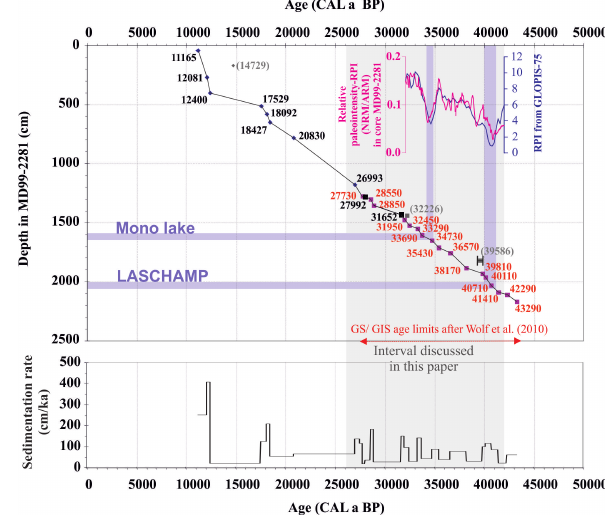
Fig. 4. Age model and sedimentation rates for the last 50kaBP in core MD99-2281 (see also Table 1). Dates in red are those de- duced from the correlation (see also Fig. 3) of the MS record and the NGRIP GICC05 δ 18 O (Wolff et al., 2010). A comparison of the relative paleointensity (RPI) record from core MD99-2281 with the reference RPI curve of GLOPIS-75 is shown for the 32–42ka